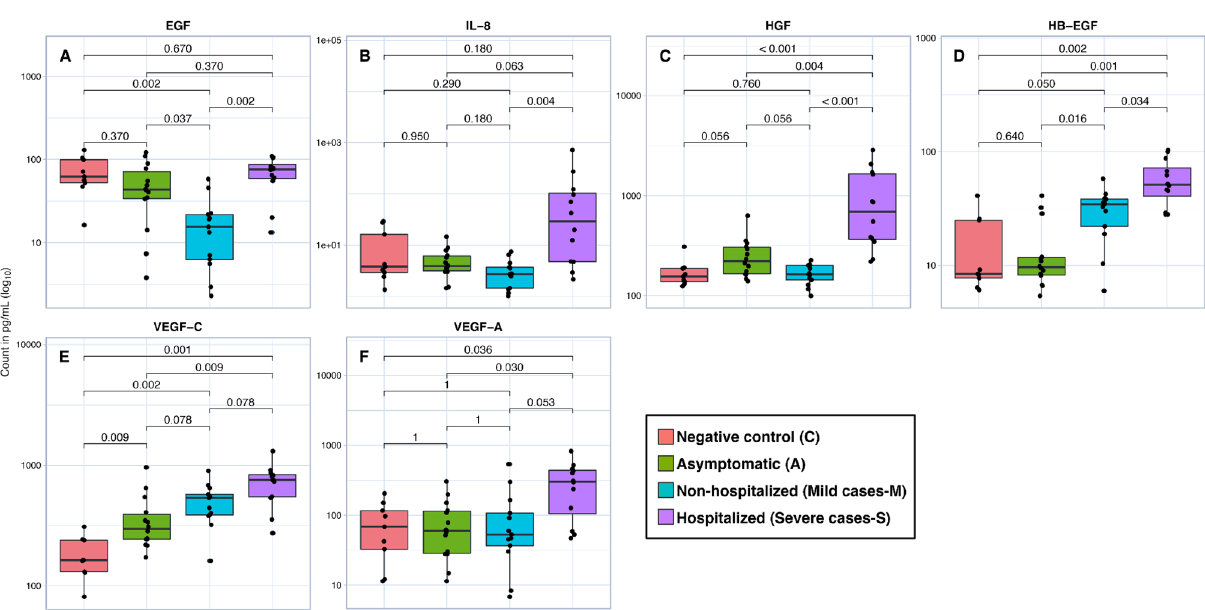
Figure 3. Box plot representation of the serum concentration (pg/mL) of angiogenesis biomarkers. Levels of EGF ( A ), IL-8 ( B ), HGF ( C ), HB-EGF ( D ), VEGF-C ( E ), and VEGF-A ( F ). The top and bottom lines of the boxes are the 25th and 75th percentiles, respectively, and the band in the middle of the box is the median. Statistical analysis was performed using the Mann–Whitney U test between the negative control (C), asymptomatic (A), nonhospitalized (mild cases-M), and hospitalized (severe cases-S)